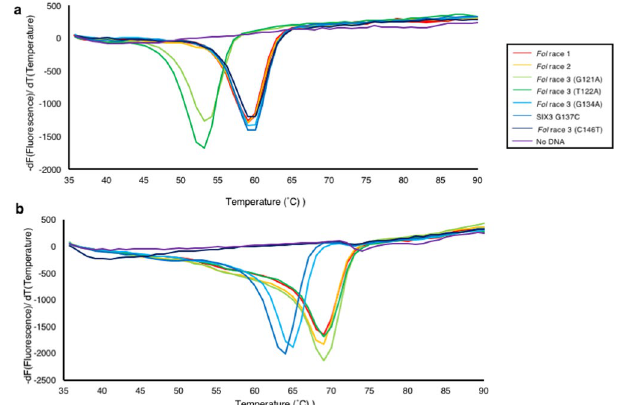
Figure 3. Melting temperature of joint DNAs combined with the universal QProbe. Melting curve analysis with Joint DNA 1 ( a ) or Joint DNA 2 ( b ) was performed from 35 to 90 °C following 60 min of LAMP reactions using genomic DNAs of Fol isolates of different races as a template. Similar results were obtained in two independent experiments.